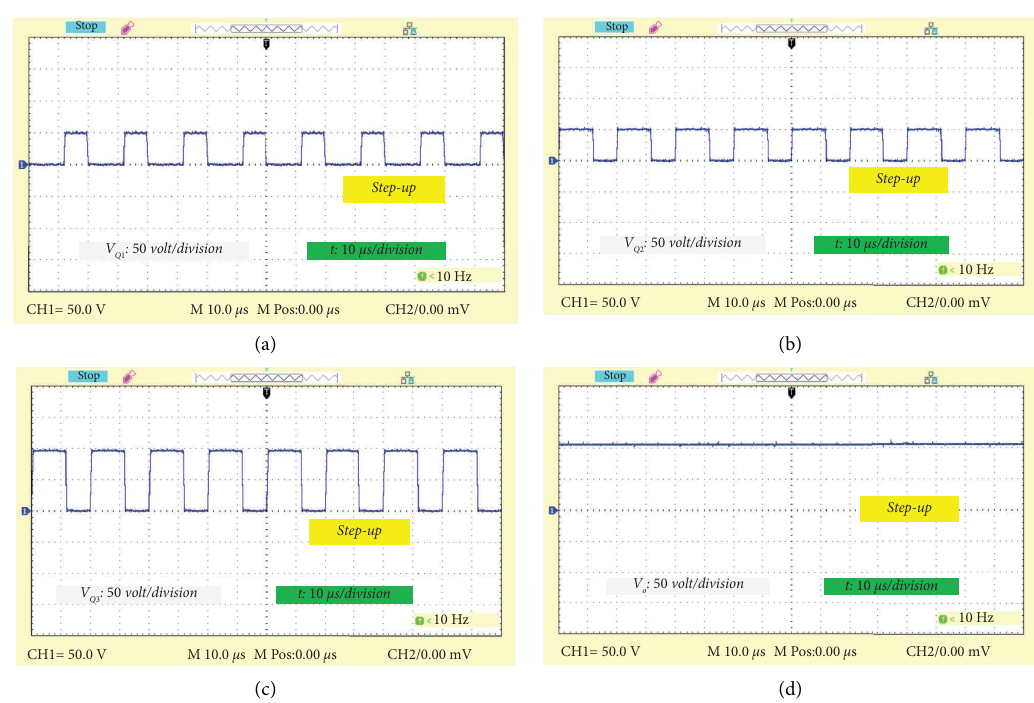
Figure 12: Voltages in step-up operation: (a) V